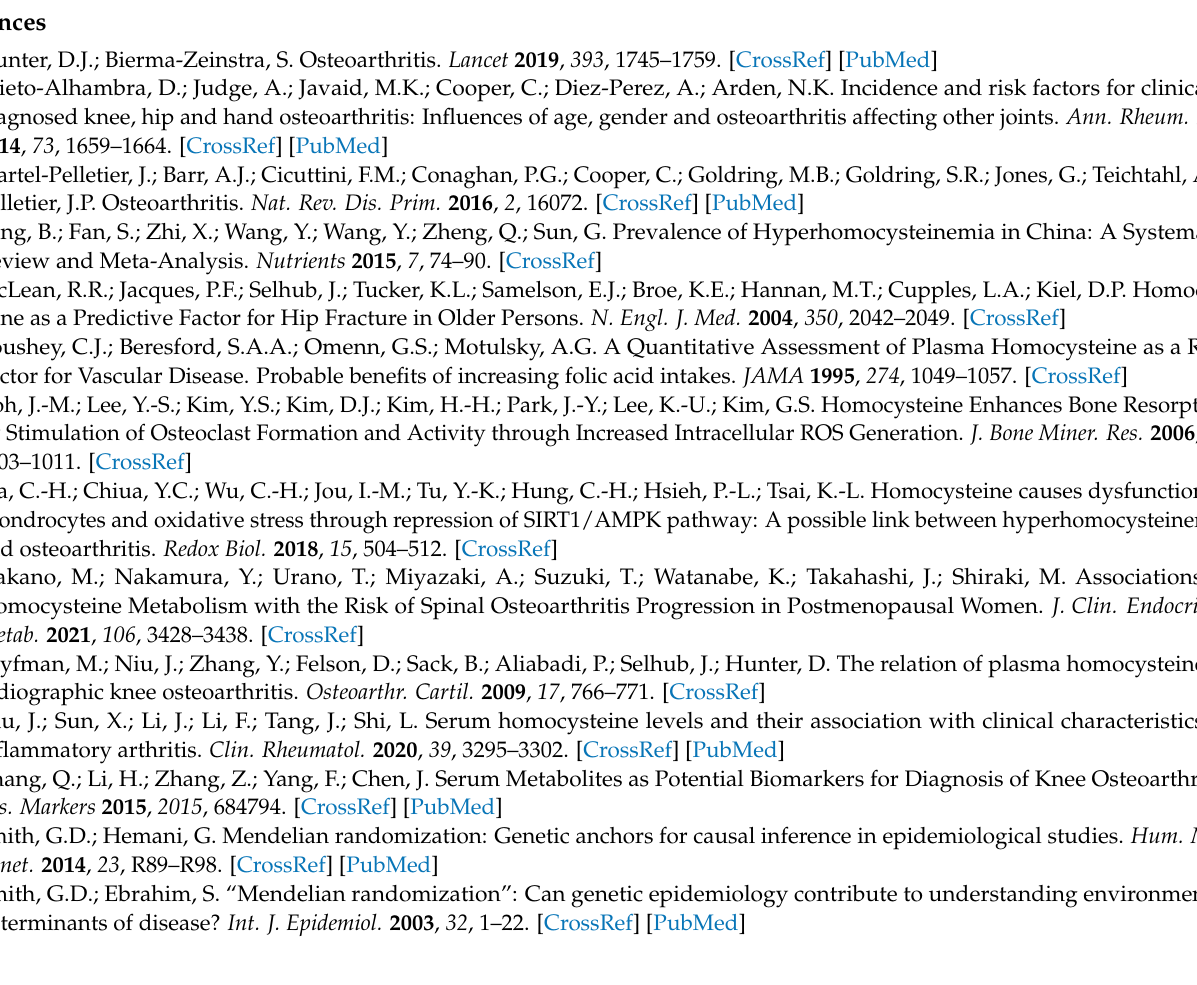
(MR-IVW). Table S6: Assessing directional pleiotropy through MR-Egger intercept and MR-PRESSO test. Table S7: Weighted median and MR-Egger methods for genetic associations between exposures and